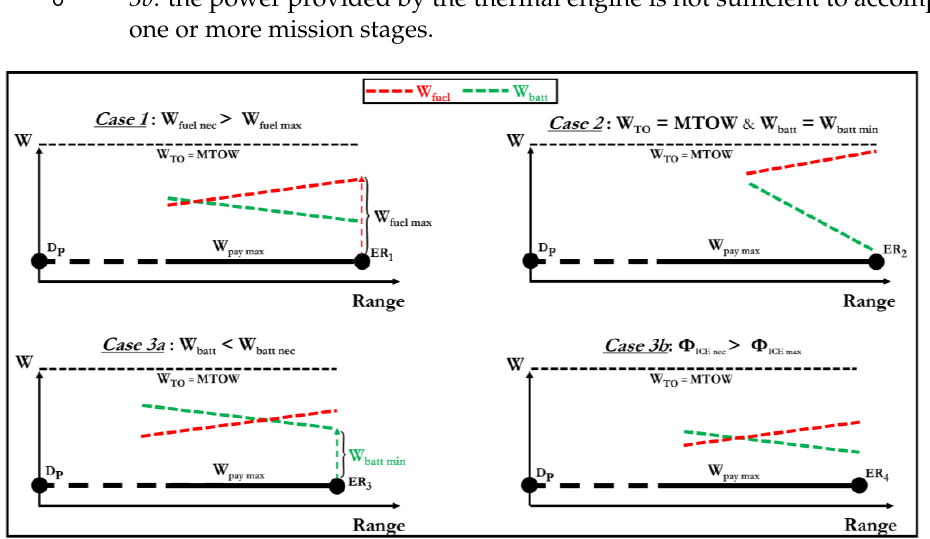
Figure 20. Four different scenarios to define the extended range.